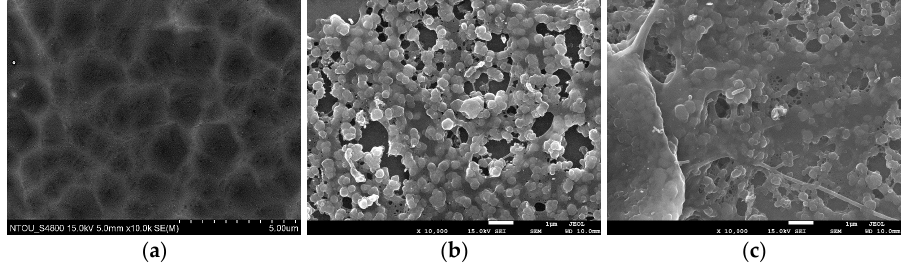
Figure 10. Surface images (×10 k) taken by scanning electron microscopy from ( a ) bare titanium alloy; ( b ) titanium alloy sequentially coated with one dopamine interlayer, four heparin/collagen multilayers, and one heparin outmost layer, Ti/Dop/(Hep_Col) 4 /Hep; and ( c ) titanium alloy, with one dopamine interlayer, nine heparin/collagen multilayers, and one heparin outmost layer, Ti/Dop/(Hep_Col) 9 /Hep.